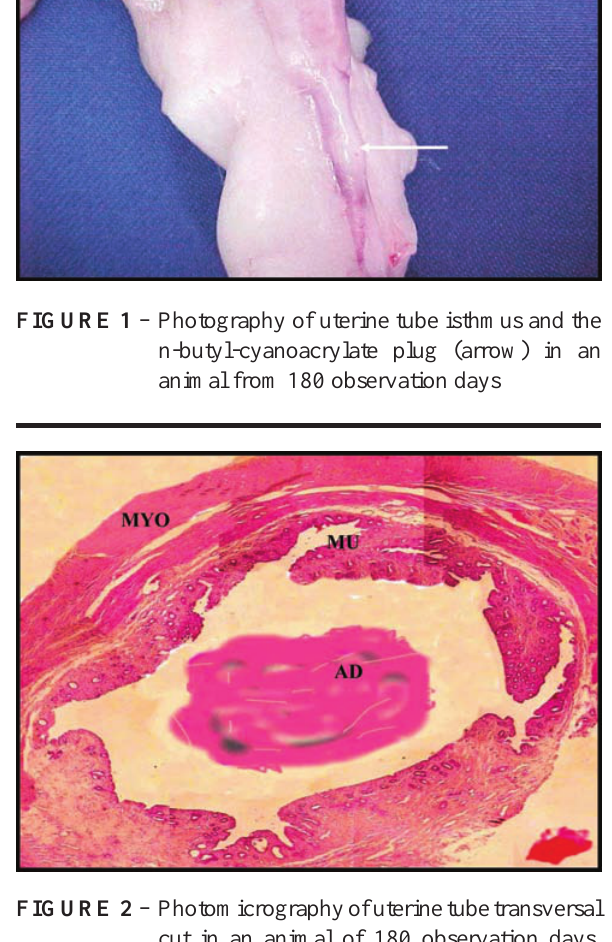
FIGURE 2 – Photomicrography of uterine tube transversal cut in an animal of 180 observation